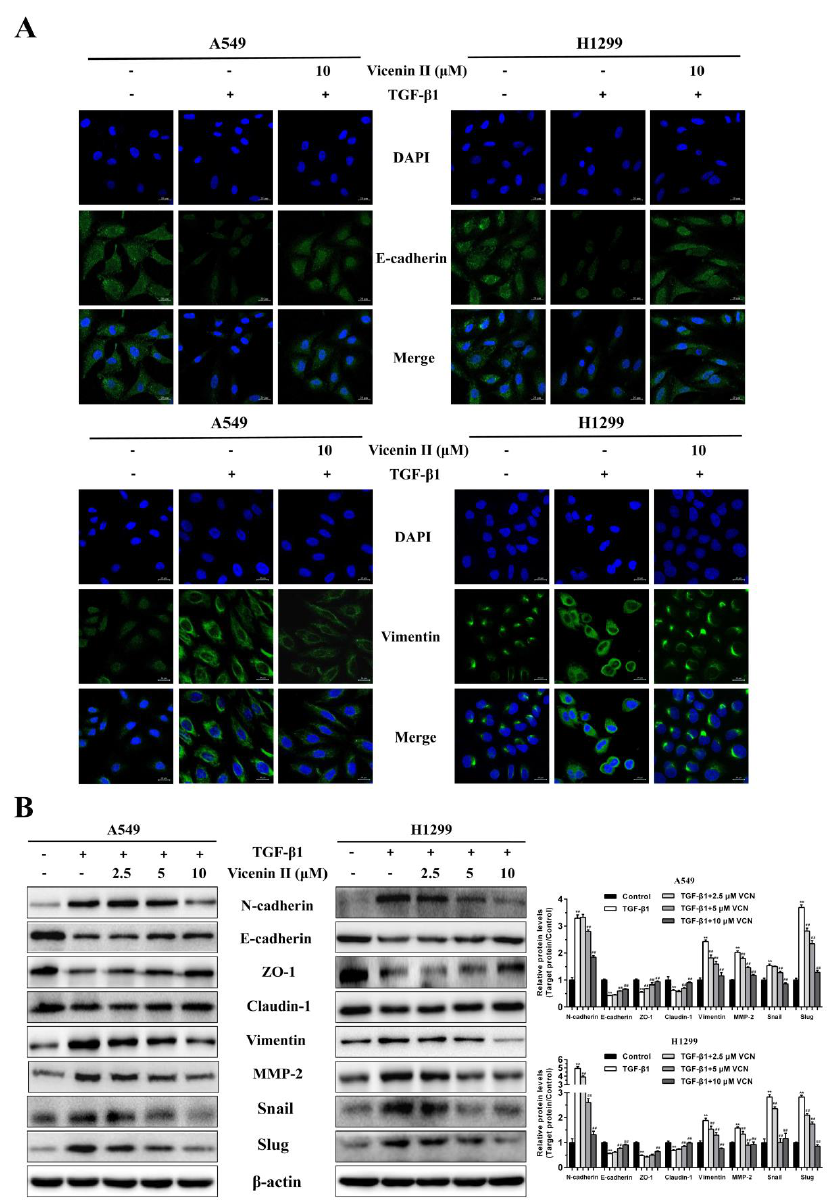
Figure 5. Effect of ViceninII on the expression of TGF- β 1-induced EMT biomarkers in A549 and H1299 cells. ( A ) After treatment with TGF- β 1 (5 ng/mL) for 48 h and co-treatment with 10 µ M ViceninII for the last 24 h, immunofluorescence staining was performed to detect E-cadherin and vimentin expression in A549 and H1299 cells by confocal microscopy. Green fluorescence indicates E-cadherin and vimentin positive expression, and blue fluorescence indicates 4 (cid:48) ,6-diamidino-2- phenylindole (DAPI)-labeled nuclei. ( B ) Cells were treated with TGF- β 1 (5 ng/mL) for 48 h and co-treated with ViceninII (2.5, 5 and 10 µ M) for the last 24 h, and the protein expression of EMT-associated biomarkers was determined by western blot analysis. Scale bars: 20 µ m. Typical graphs and a histogram (mean ± SD) are shown, n = 3. ** p < 0.01 compared with the control group; ## p < 0.01 compared with the TGF- β 1-treated